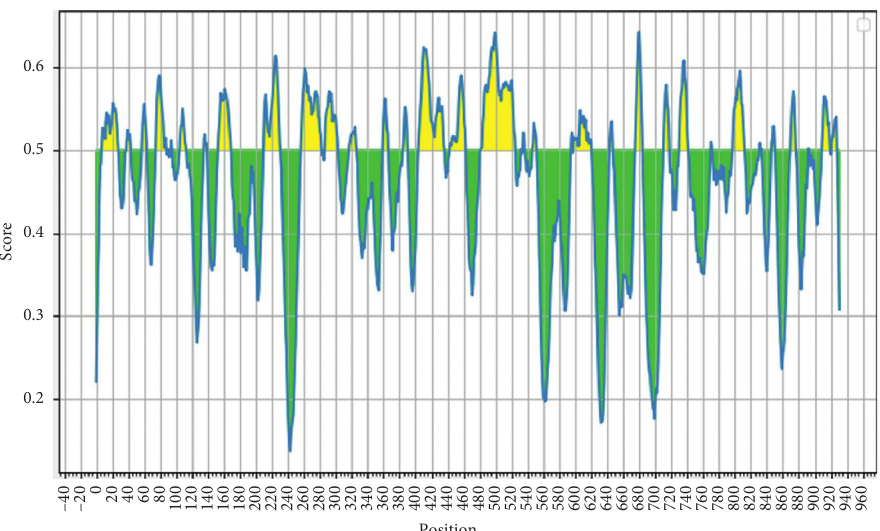
Figure 3: B-cell epitope prediction of RdRp protein sequence. The threshold cutoff is 0.4, above which the residues are Table 3: T-cell epitope prediction of SARS- CoV-2 RdRp protein sequence from India and its allergenicity. Peptide